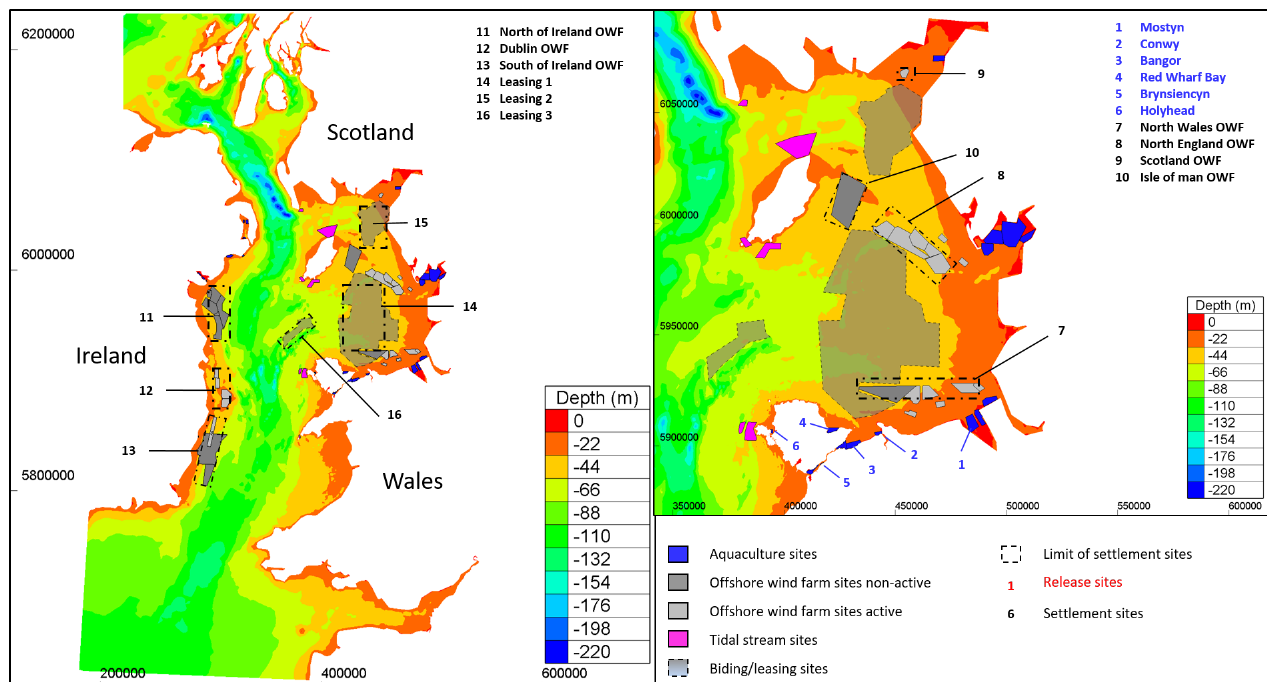
Fig. 1. Domain of study showing the Irish Sea hydrodynamic model domain (WGS84 coordinates in m) and bathymetry (m relative to MSL), the larval release and sink sites (1-6 in blue), plus additional sink sites only (black dashed-dotted area